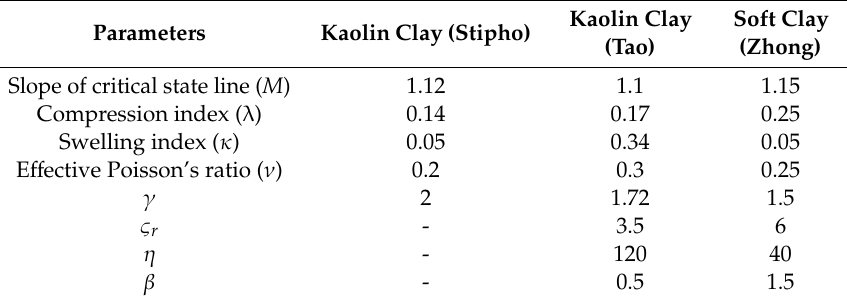
Table 2. Model parameters in verification cases.